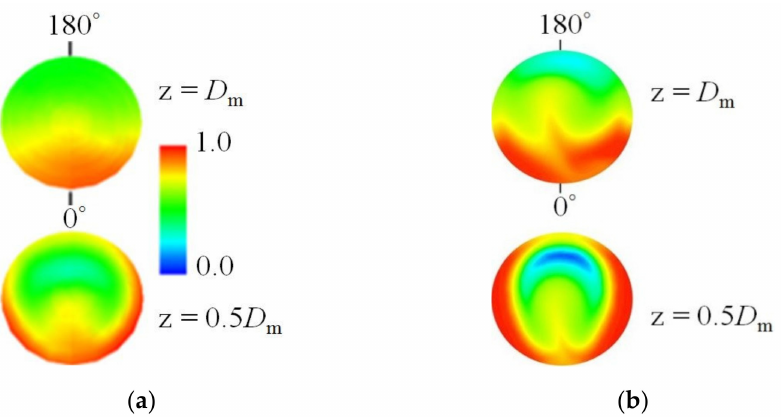
Figure 9. Distribution of the dimensionless temperature T* at Re m /Re b = 0.91: ( a ) LES [9]; ( b )